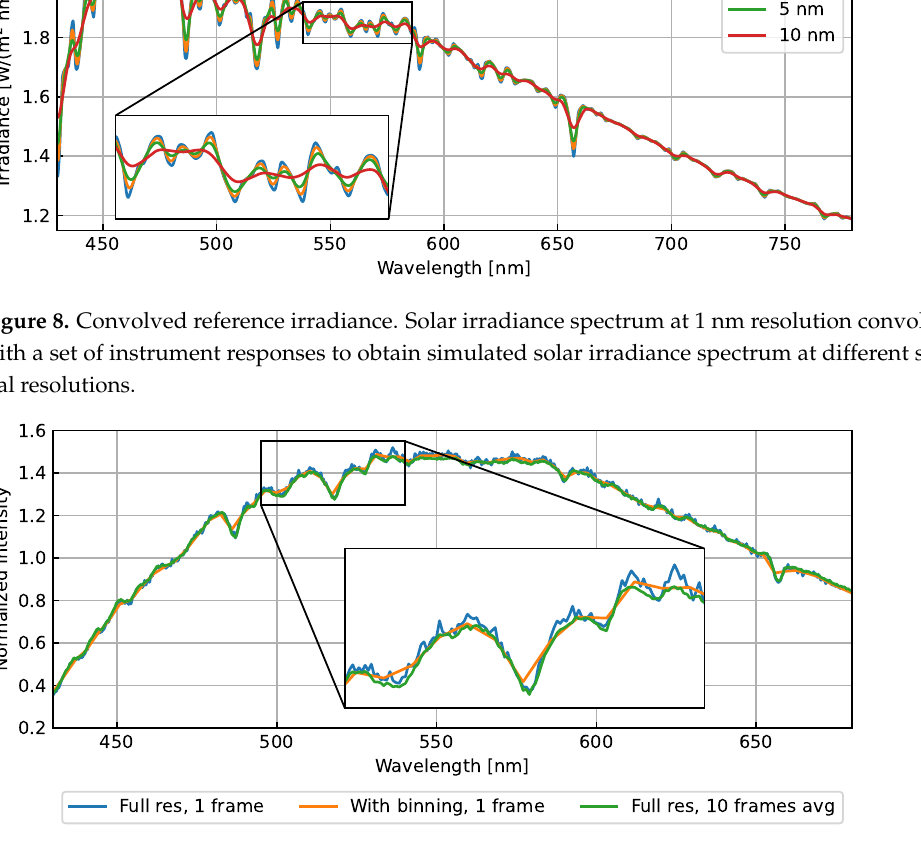
Figure 9. Raw spectrum of the Moon captured by HYPSO-1, with (orange) and without (blue) binning (spectrally binning nine pixels). Reducing noise by averaging 10 frames (without binning) is shown in green. Normalized intensity is recorded digital counts divided by the mean value in the spectrum. For further analysis, a low-pass filter is applied to smooth the full resolution data to reduce noise, and a high-pass filter applied to both the HYPSO-1 data and the reference data to remove slow intensity changes. The datasets are then normalized by scaling with their maximum values. The resulting filtered and normalized responses of the reference spectrum and full resolution data (1 frame) are shown in Figure 10, showing comparable features from the Fraunhofer lines in the datasets.